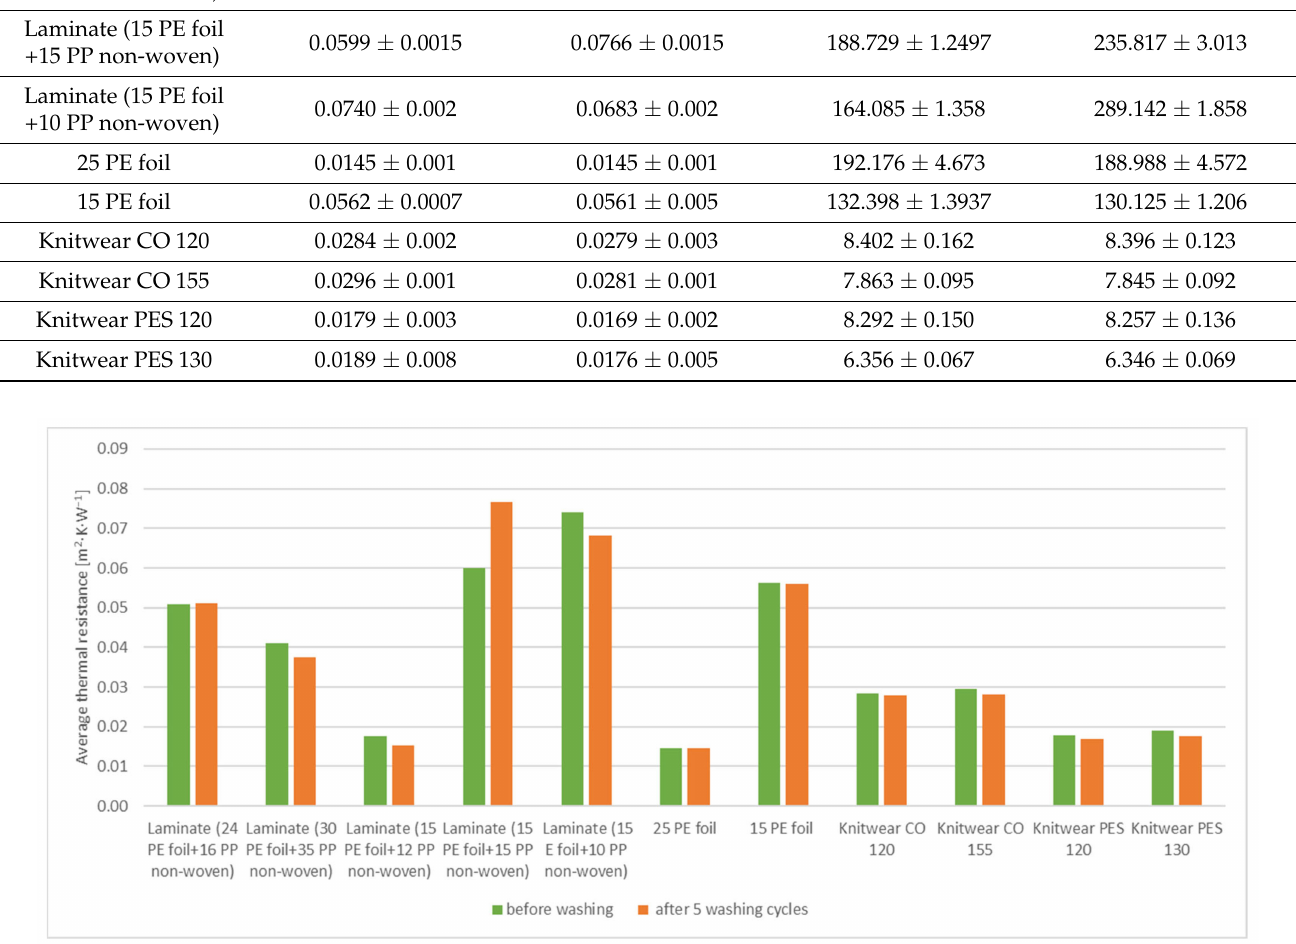
Figure 10. Average thermal resistance results: before and after 5 washing